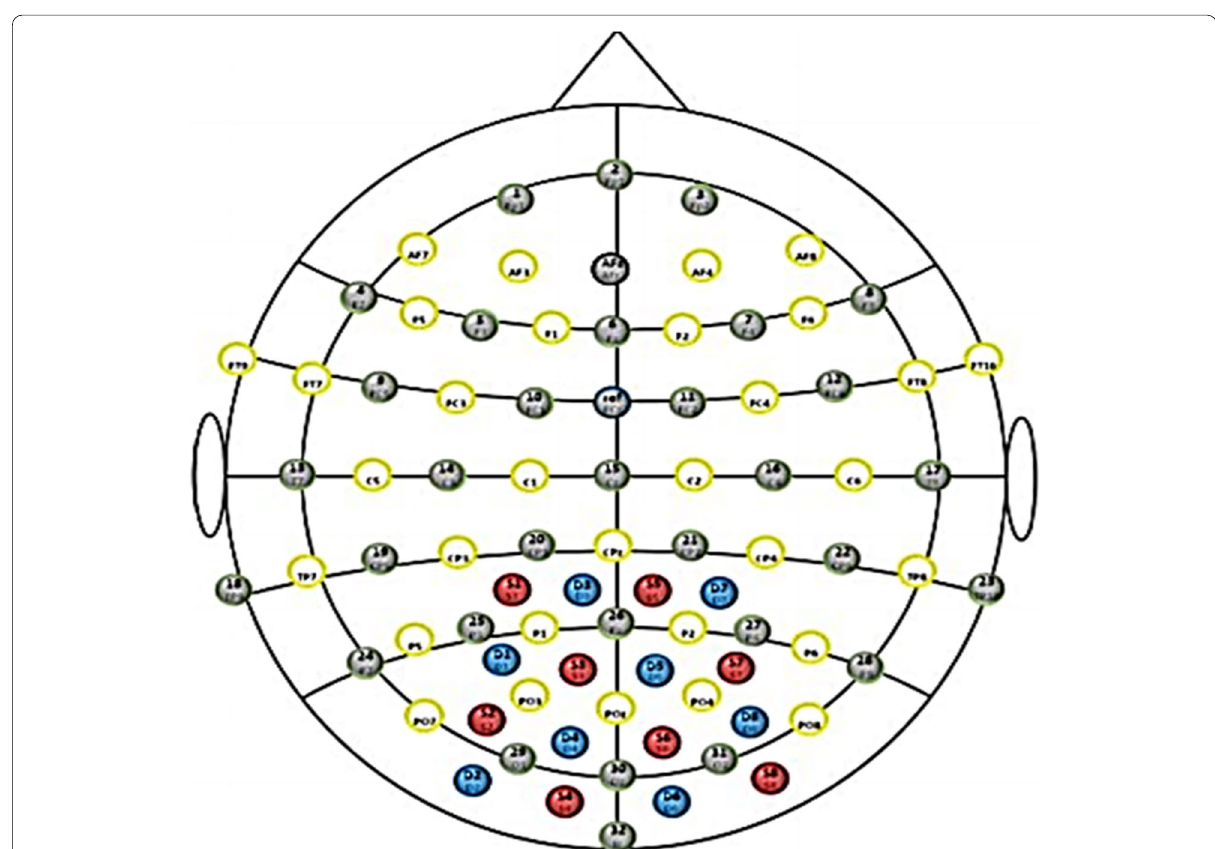
Fig. 1 fNIRS monitoring with 16 channels in parieto-occipital area. The red circles indicate sources. The blue circles represent